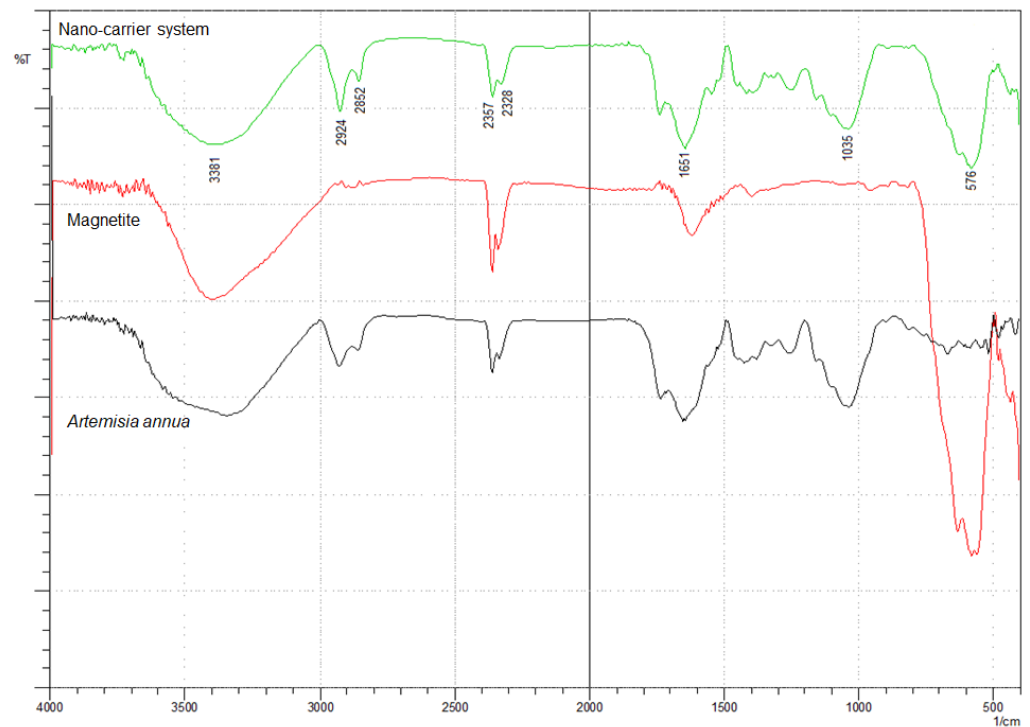
Figure 4. FT-IR spectra of Artemisia annua , magnetite nanoparticles and nano-carrier system. The FT-IR spectra of the herb display the characteristic absorption peaks of Artemisia annua (Figure 4). The characteristic group frequencies of different organic molecules detected in Artemisia annua can be attributed to flavonoids (1703, 1580, 1460, 630 and 575 cm − 1 ), amino acids (1651, 1580, 1555 and 1545 cm − 1 ), terpenoids (1740, 1651